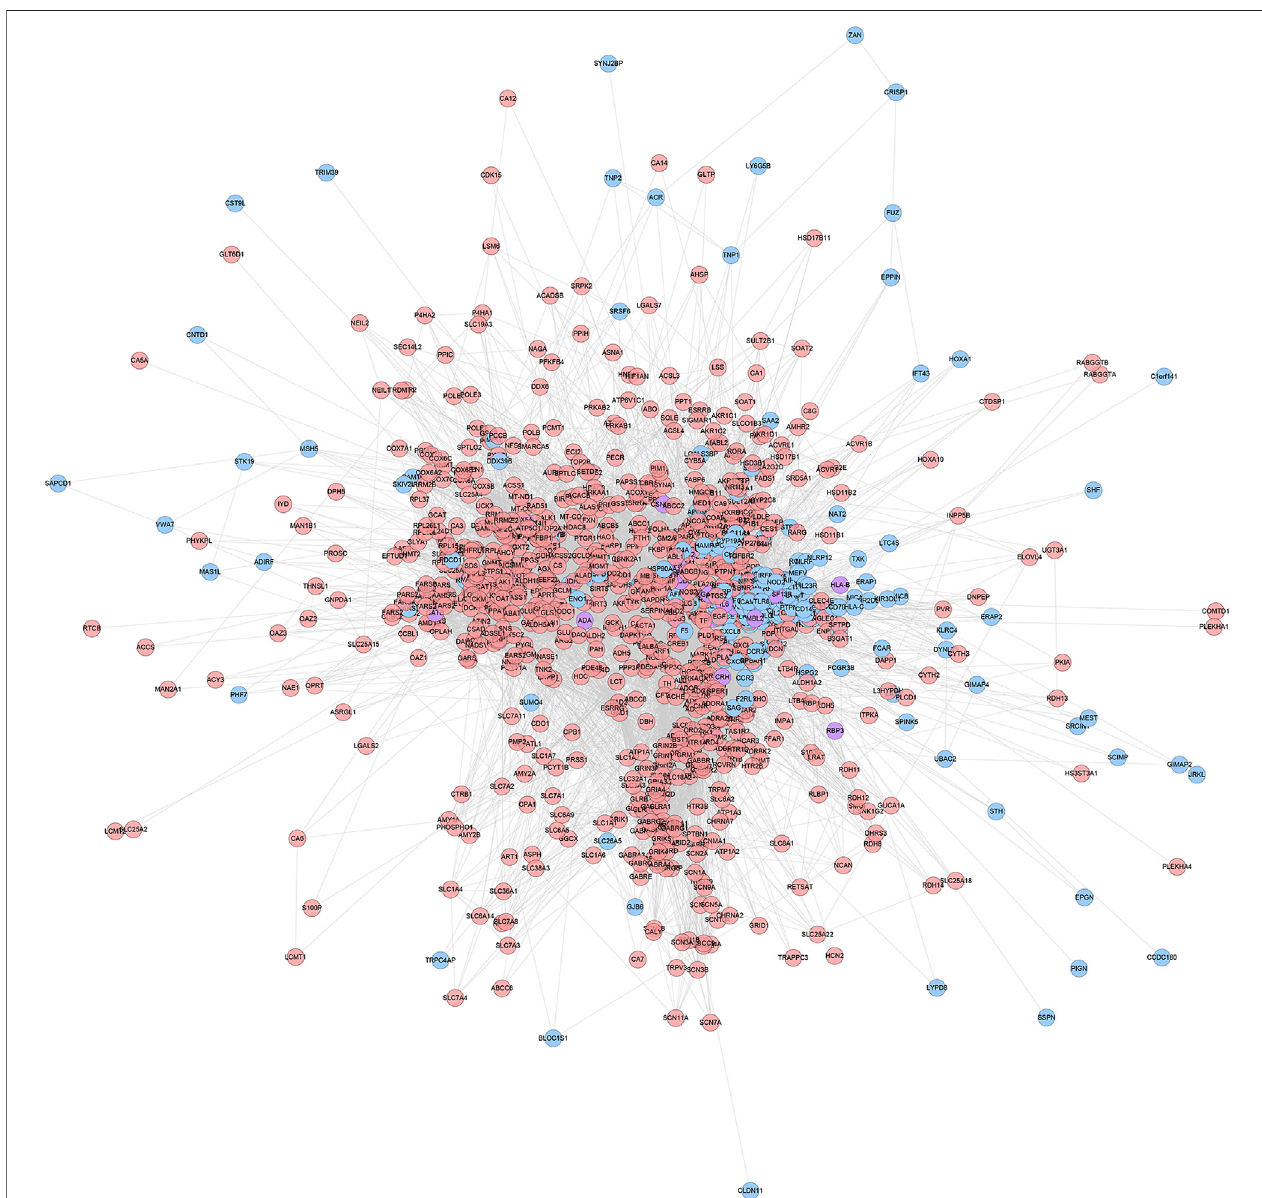
FIGURE 3 | ZBDHD-orchitis PPI Network (Pink circles stand for ZBDHD target, Blue circles stand for orchitis targets, purple circles stand for ZBDHD-orchitis